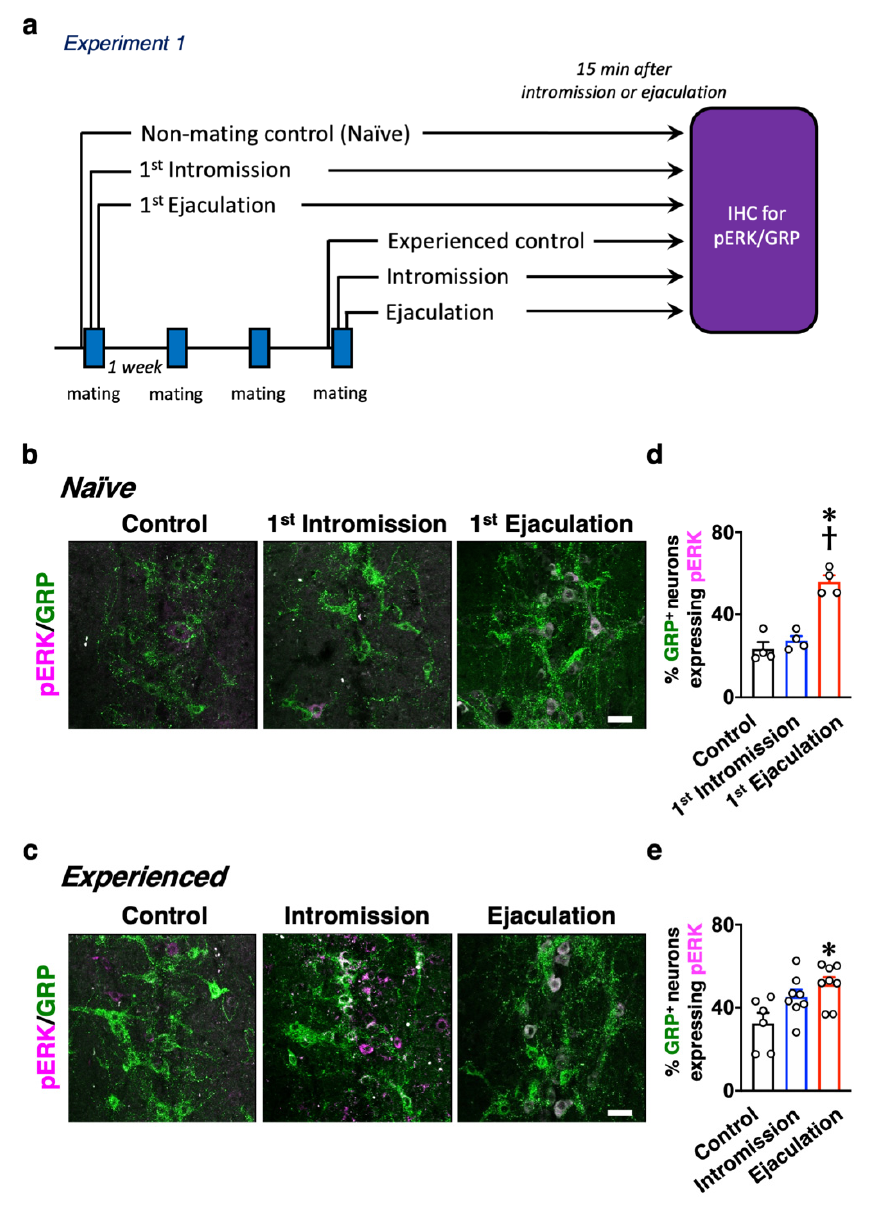
Figure 1. ( a ) Experimental paradigm of Experiment 1: changes in the activation of dXL neurons between naïve and sexually experienced male rats. Activation of spinal GRP-positive ( + ) neurons after sexual behavior in male rats with or without sexual experience. ( b ) Expression of phosphorylated extracellular signal-related kinases 1 and 2 (pERK) (magenta) in spinal GRP + neurons (green) after sexual behavior of sexually naïve males. Left panel, Control. Middle panel, 1st-Intromission group. Right panel, after 1st Ejaculation. ( c ) Expression of pERK (magenta) in spinal GRP + neurons (green) after sexual behavior of sexually experienced males. Left panel, Control. Middle panel, mounts and intromission only. Right panel, after ejaculation. ( d ) In naïve males, ejaculation significantly